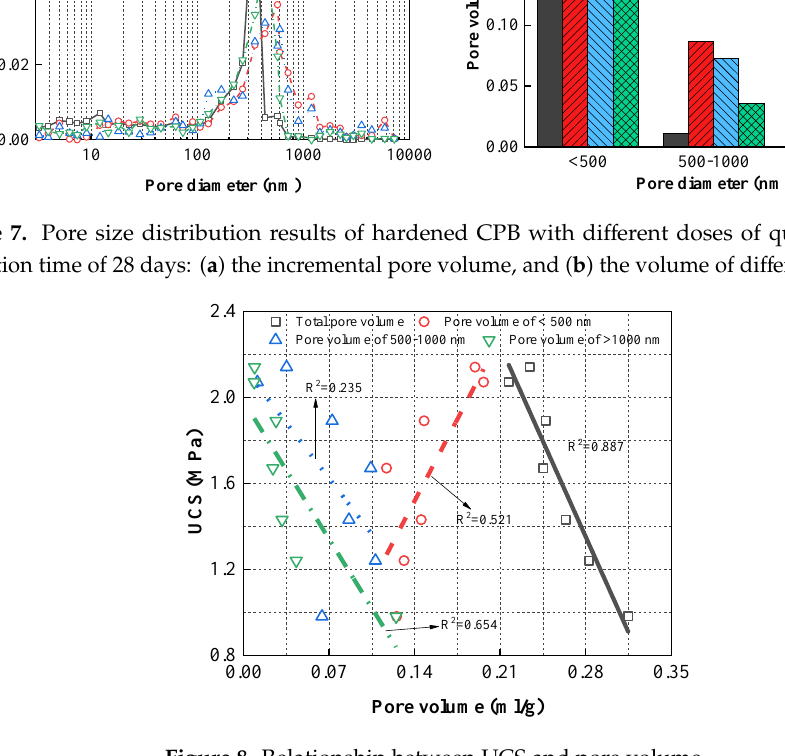
Figure 8. Relationship between UCS and pore volume.